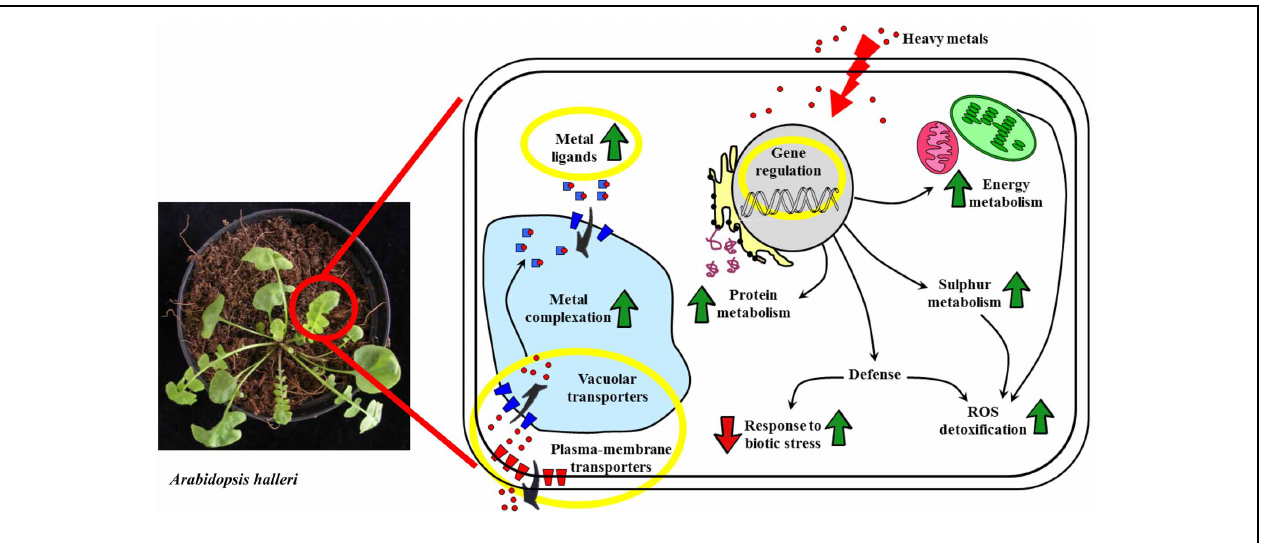
FIGURE 1 | Schematic representation ofthecellular mechanisms responsible fortheheavy metal accumulationtraitthathave been identifiedthroughdifferential proteomicsapproaches. Processes that are